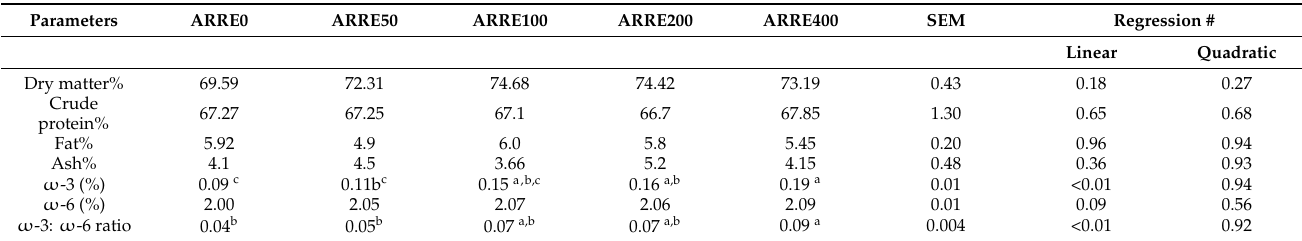
Table 4. The effect of dietary supplementation of ARRE on the chemical and fatty acid composition of the breast muscle.